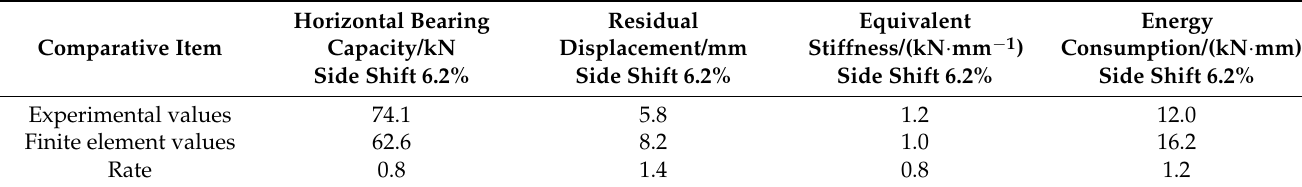
Table 4. Comparison between simulated values and experimental values.